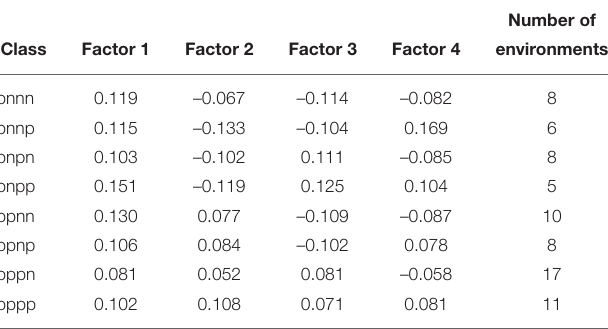
Frontiers in Plant Science |